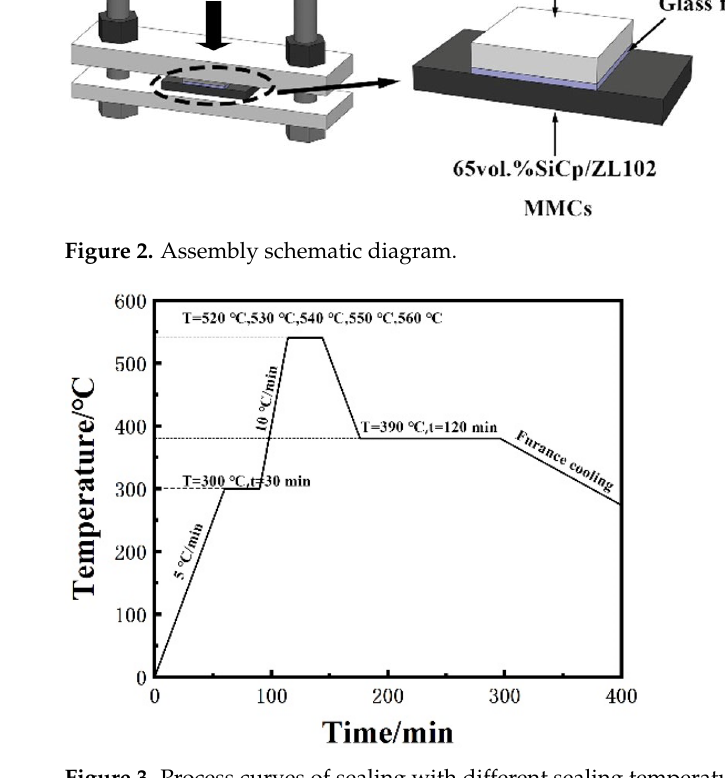
Figure 3. Process curves of sealing with di ff erent sealing temperatures.